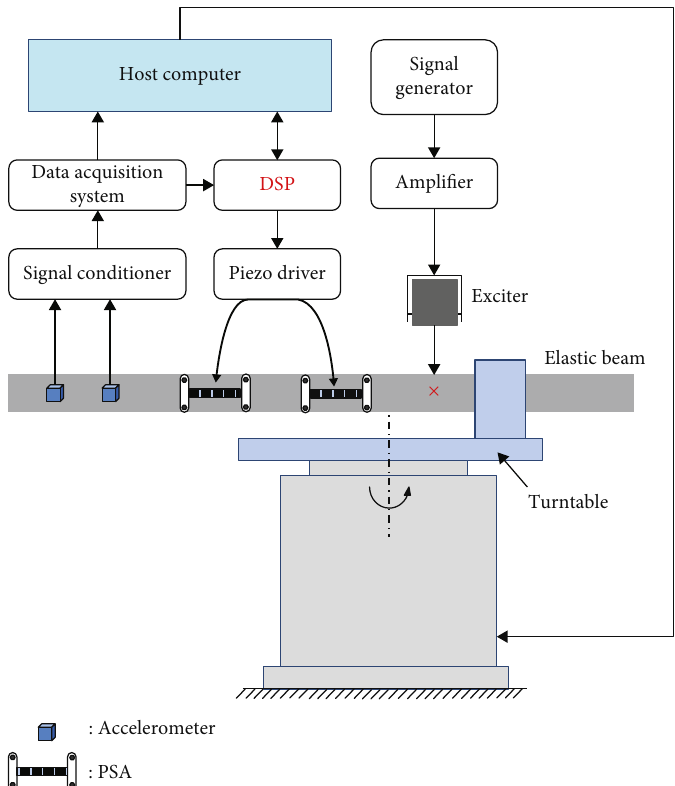
Figure 8: Block diagram of the elastic beam rotary ACSR test system.